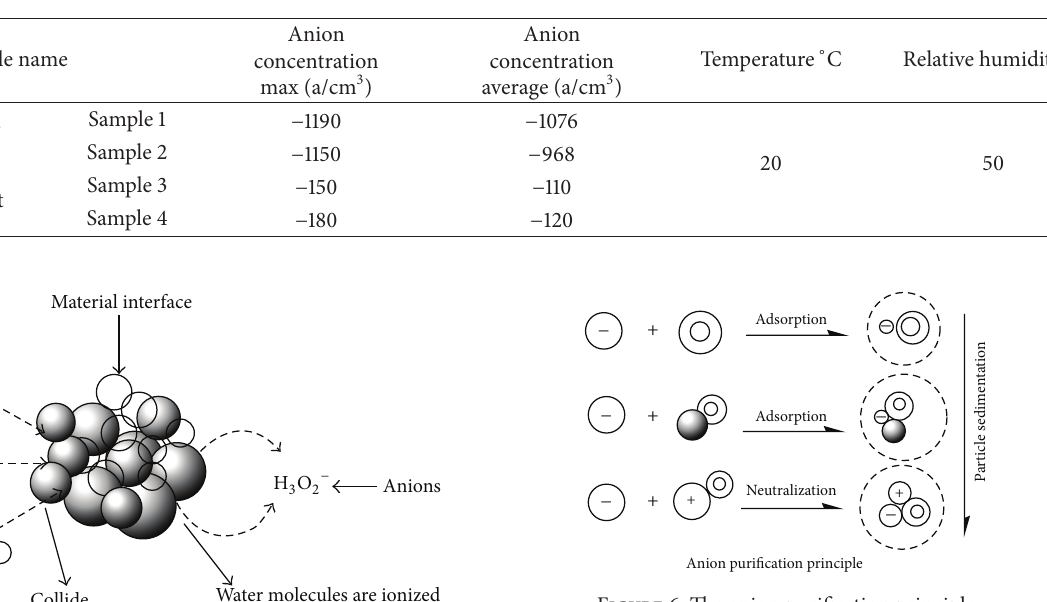
Table 1: The results of asphalt pavement anion test.